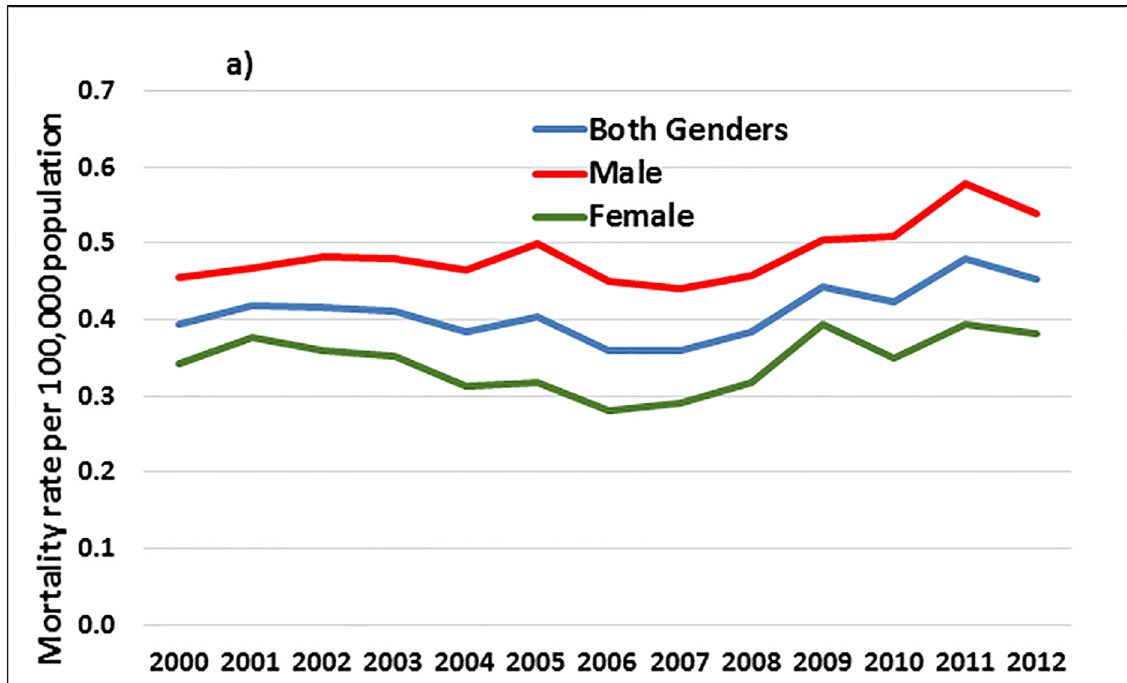
PLOS ONE | https://doi.org/10.1371/journal.pone.0181708 July 20,